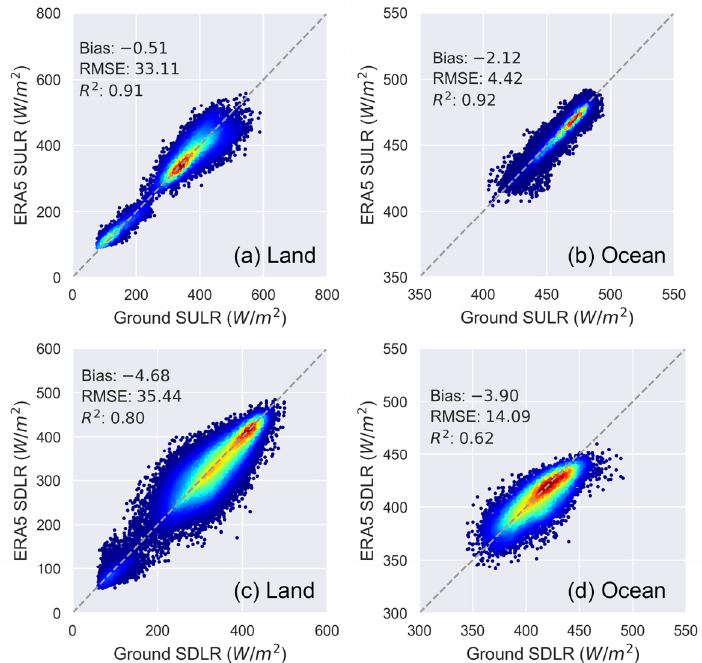
Figure 9. Validation of the European Centre for Medium-Range Weather Forecasts (ECMWF) Reanalysis v5 (ERA5) surface longwave radiation using site measurements. ( a ) ERA5 surface upward longwave radiation (SULR) based on Baseline Surface Radiation Network (BSRN) data; ( b ) ERA5 SULR based on Global Tropical Moored Buoy Array (GTMBA) data; ( c ) ERA5 surface downward longwave radiation (SDLR) based on BSRN data; and ( d ) ERA5 SDLR based on GTMBA data. The color indicates the density of sampling points, with higher density in red and lower density in blue.